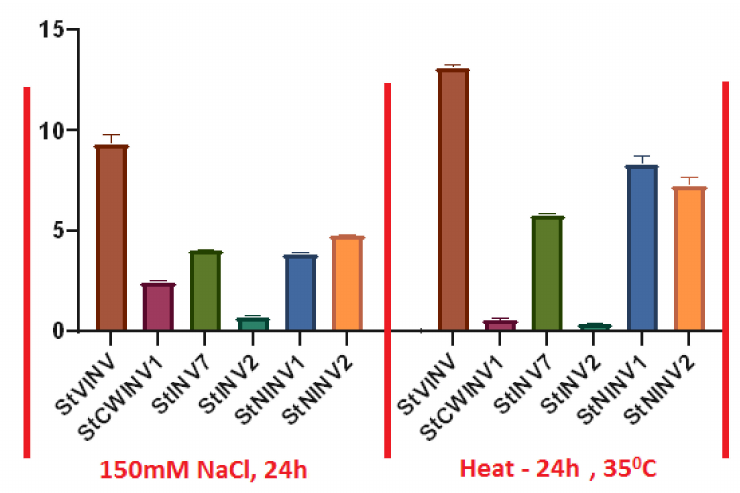
Figure 10. Expression pattern of invertase genes under salt and heat stress. Fold change values were plotted, StActin97 was used as internal control for three biological replicates of each sample in the experiment. Bars are drawn for SD.